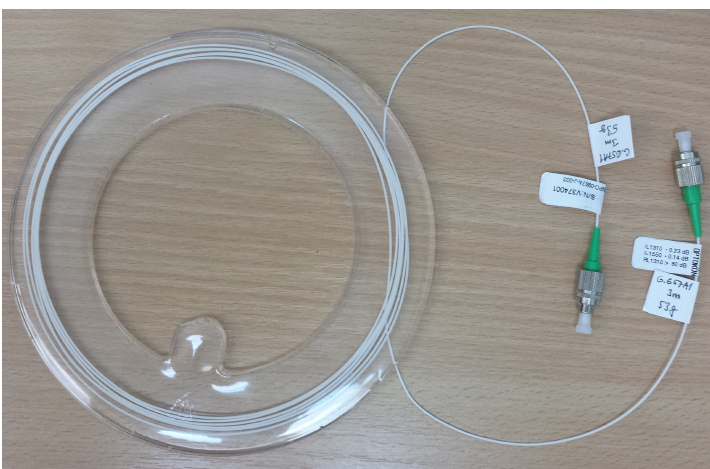
Figure 2. Noninvasive interferometric measurement probe.